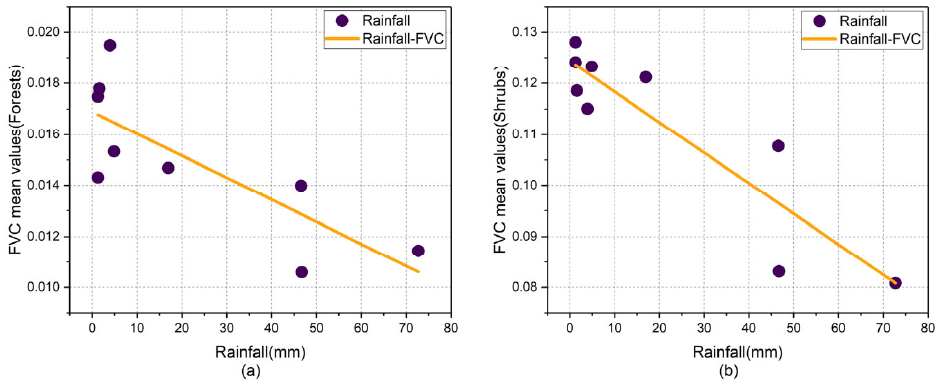
Figure 9. Rainfall and vegetation regeneration relationship map: ( a ) forests-rainfall and ( b ) shrubs-rainfall. Post-Fire Vegetation Regeneration—Daytime